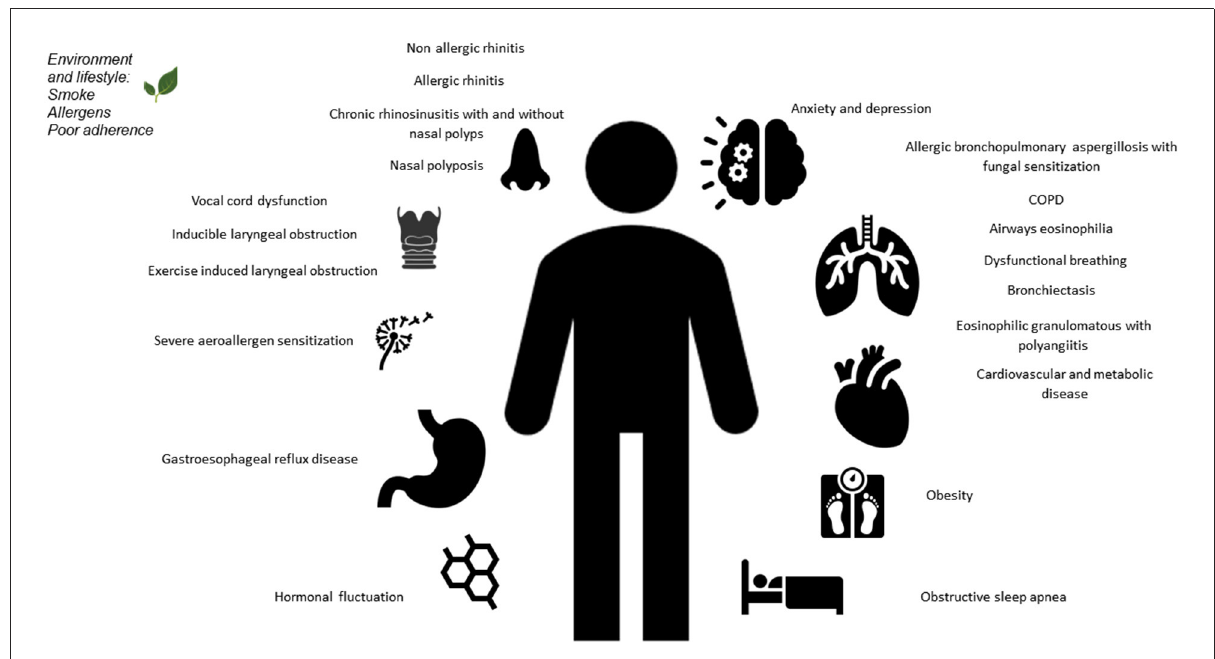
FIGURE1 Overview of pulmonary and extrapulmonary comorbidities in severe asthma, in adults and children.